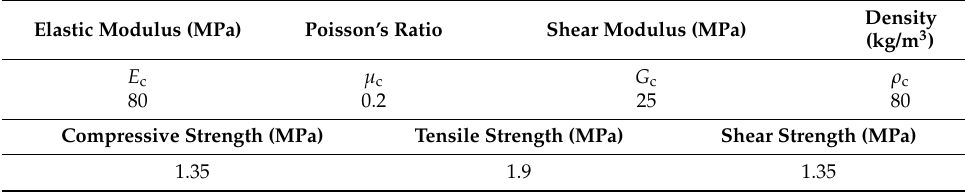
Table 3. Mechanical parameters of the PVC foam.